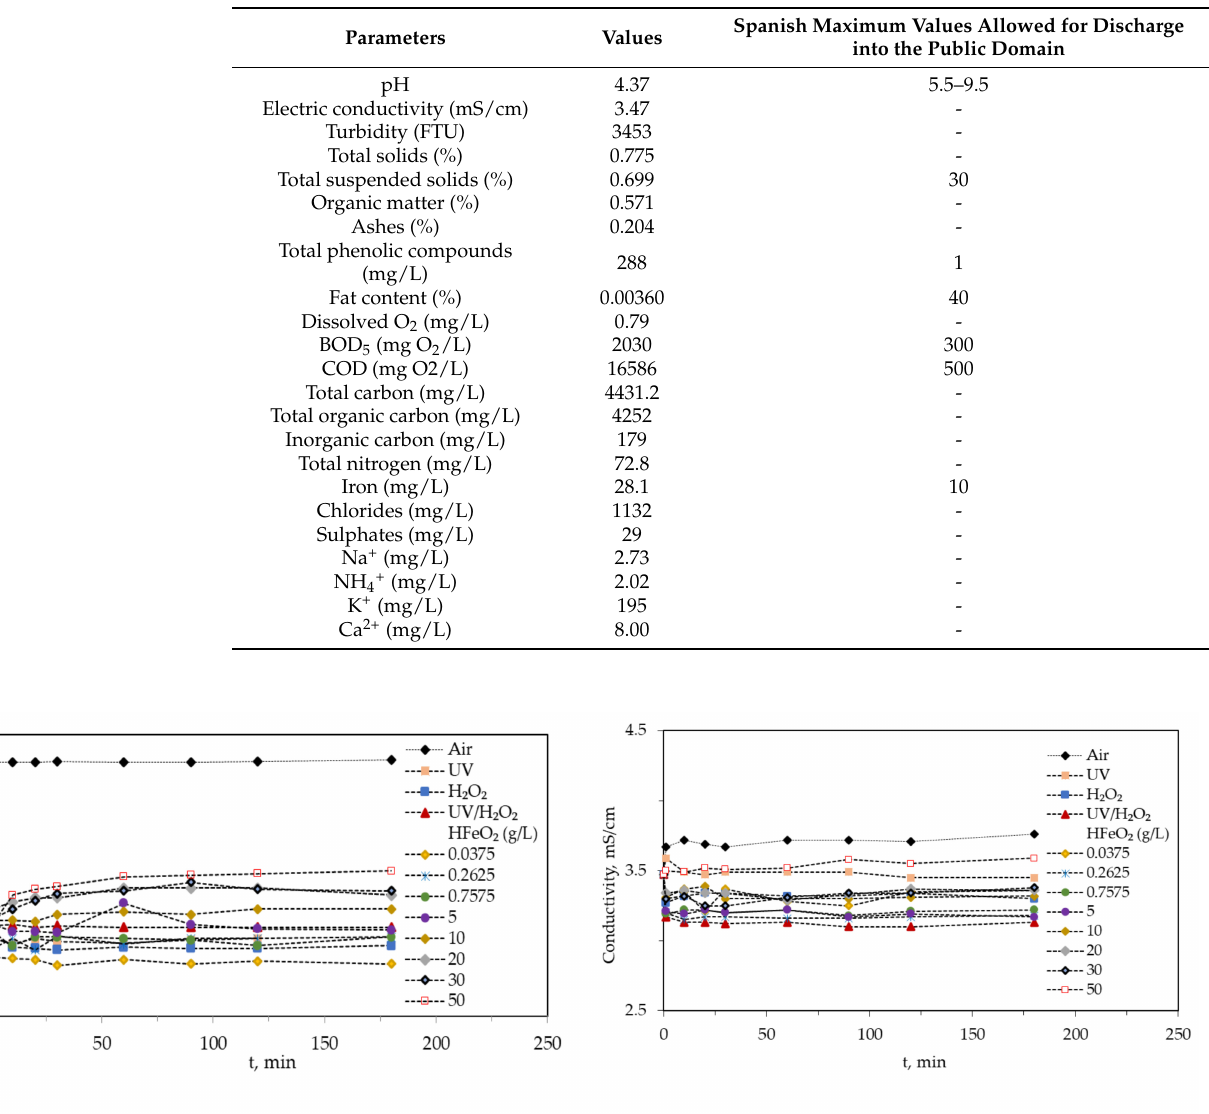
Table 1. Characterization of a mixture of OMW used as the initial sample and the Spanish maximum values allowed for discharge into the public domain (Royal Decree 849/1986).